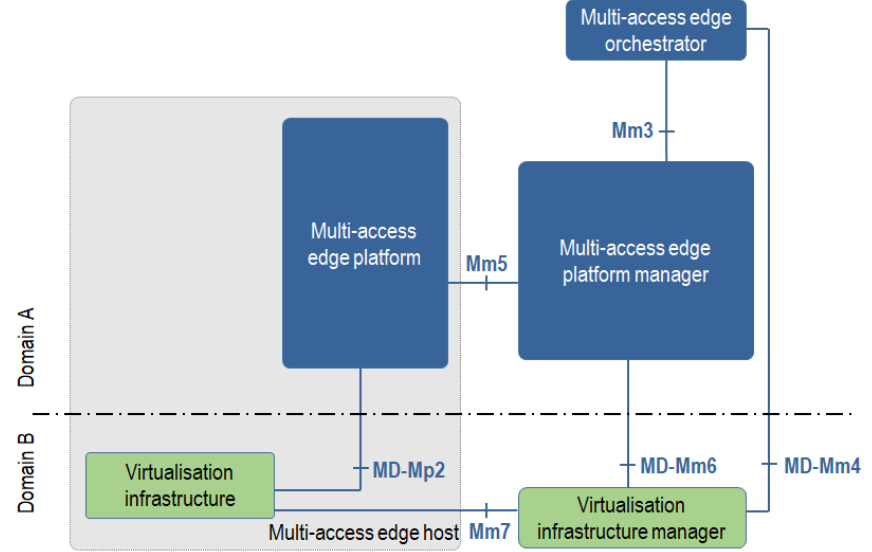
Figure 2. Integration of MEC providers at infrastructure level following an Infrastructure-as-a-Service (IaaS) approach.